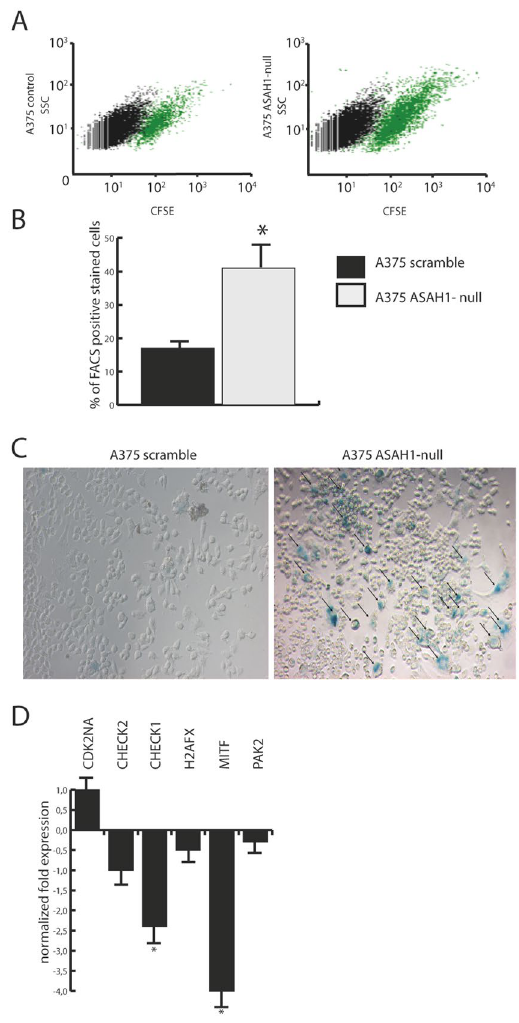
Figure 4. AC deletion accelerates senescence. ( A ) Flow cytometry of senescence-associated β -galactosidase on control (scramble-treated, left) and ASAH1 -null A375 cells. ( B ) Number of β -gal positive cells in